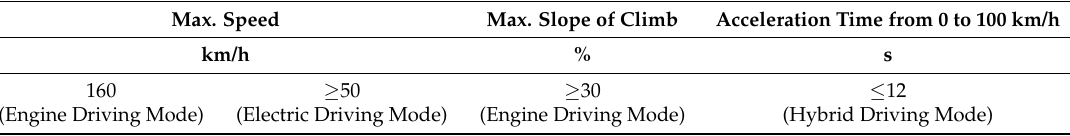
Table 3. Constraints of dynamic performance for the HEV.